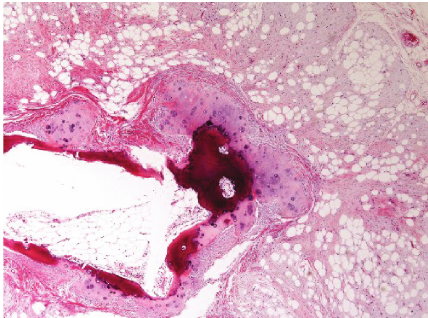
Figure 2: Case 2. Fibrolipoma with osseous/chondroid di ff erenti- ation. Mature fat cells are supported by fibrous connective tissue with myxoid change and cartilage nodule associated with trabecular bone tissue in it (HE, original magnification ×